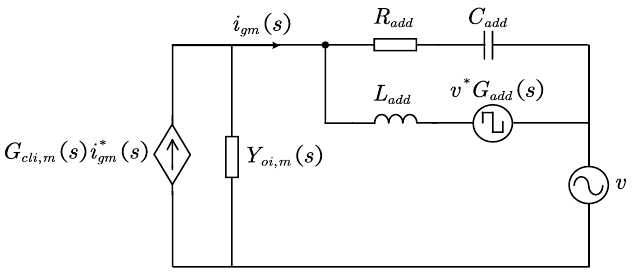
Figure 9. Equivalent structure diagram of the modified topology.